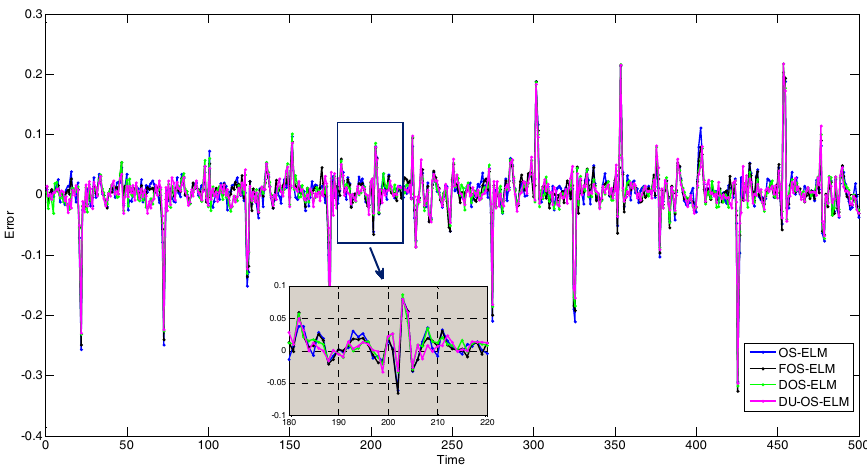
Figure A2. Simulation results of Mackey-Glass chaotic time series.